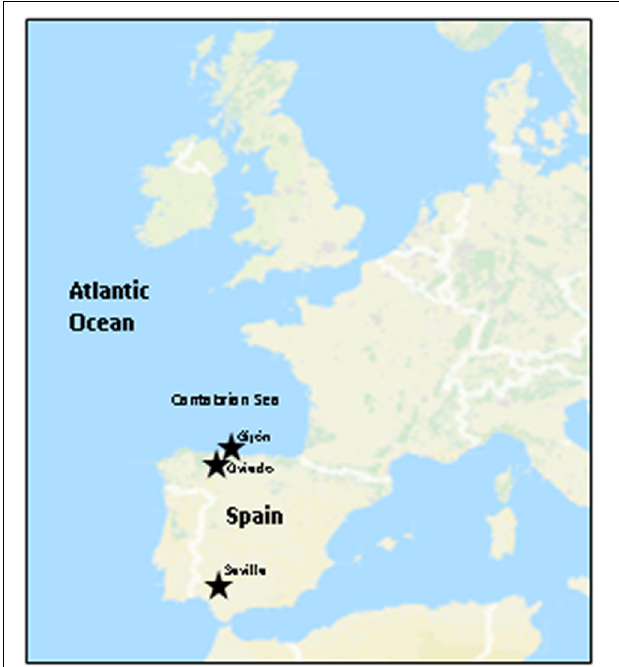
FIGURE 1 | Sampling locations in Spain. Overview of the European Seas (Atlantic Ocean). Stars indicate the sampling locations in Northern and Southern